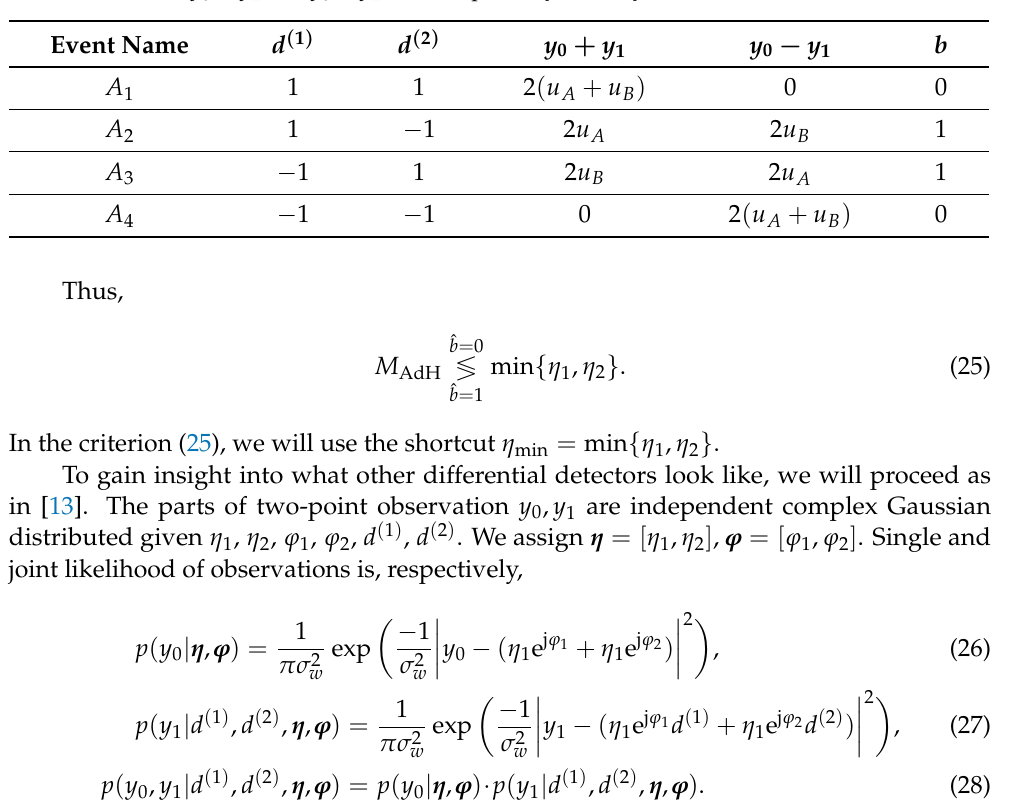
Table 1. Values of y 0 + y 1 and y 0 − y 1 for all tuples of [ d ( 1 ) , d ( 2 ) ]